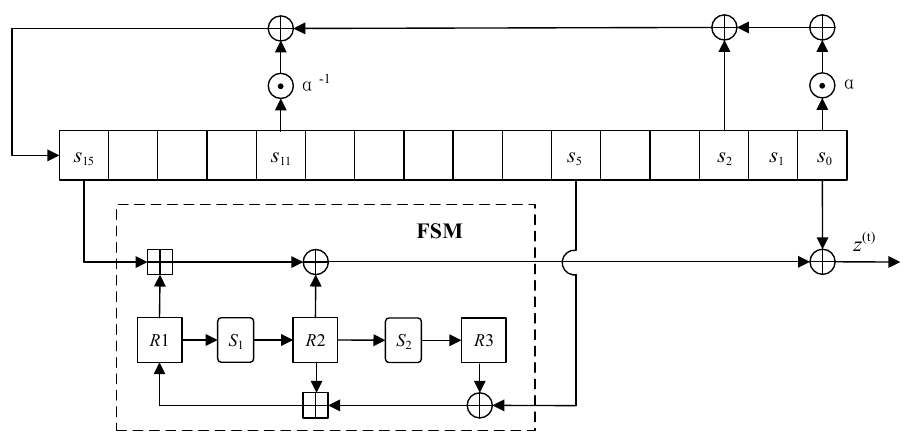
Figure 1: The keystream generation phase of the SNOW-3G stream